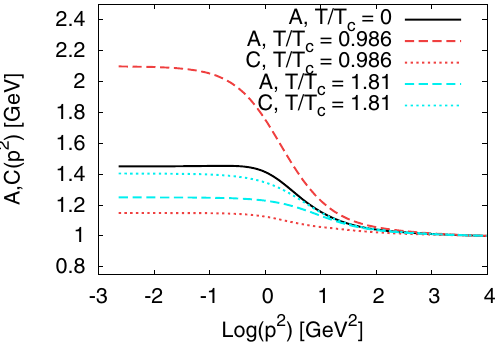
Fig. 4. The Landau gauge quark renormalization functions A ( p 2 ) and C ( p 2 ) (see Eq. (5)) for di ff erent temperatures in the chiral